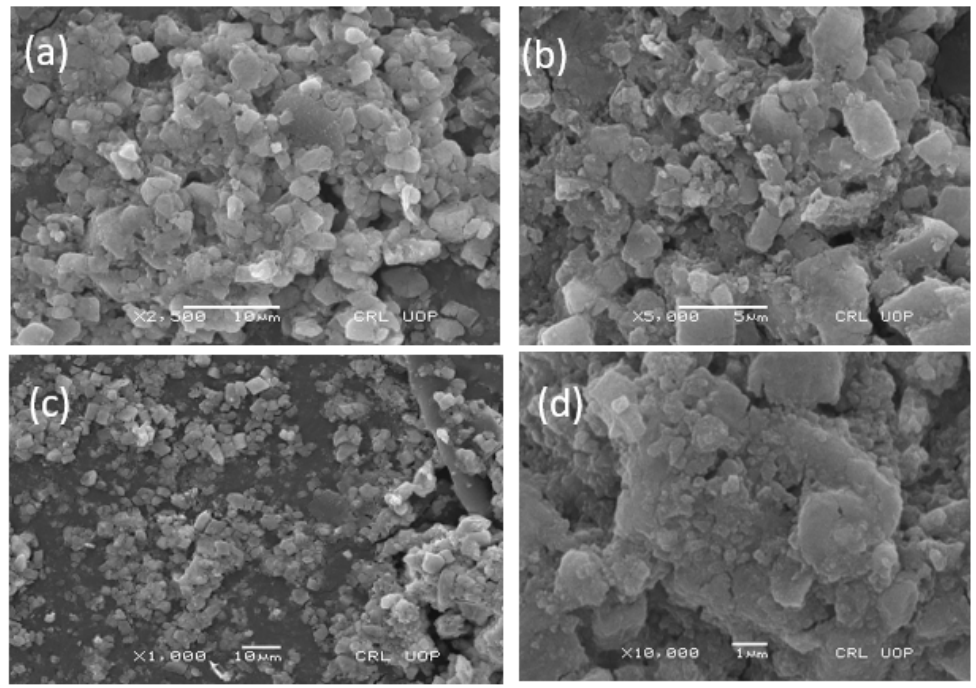
Figure 5. ( a ) 2500 resolution ( b ) 5000 resolution and ( c , d ) are same resolution of Scanning electron microscopy image of the zinc oxide nanoparticles at various magnifications.